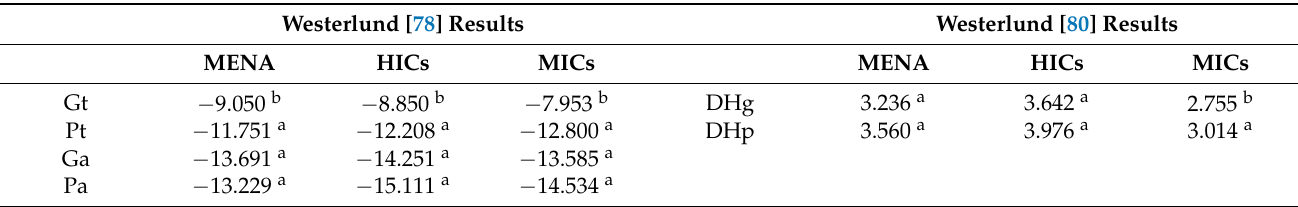
Table 8. Westerlund [78,80] Cointegration